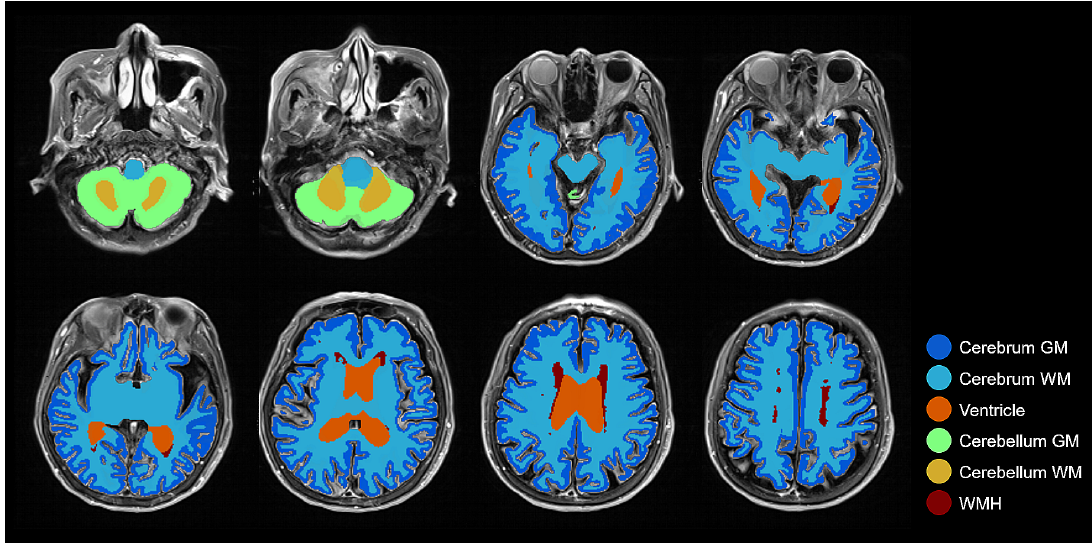
Figure 7. Combined brain tissue and WMH label on FLAIR MRI with several layers demonstrating all labels: Cerebrum GM, Cerebrum WM, Ventricle, Cerebellum GM, Cerebellum WM, and